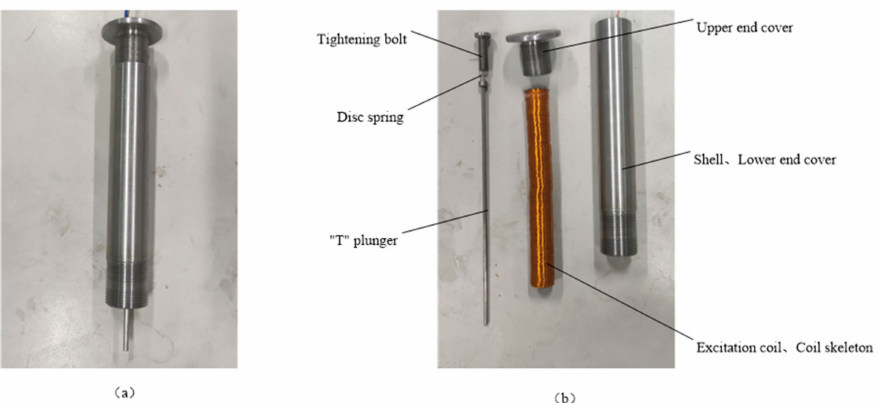
Figure 6. GMA prototype for direct-drive injector: ( a ) Overall drawing of device; ( b ) exploded diagram of device.